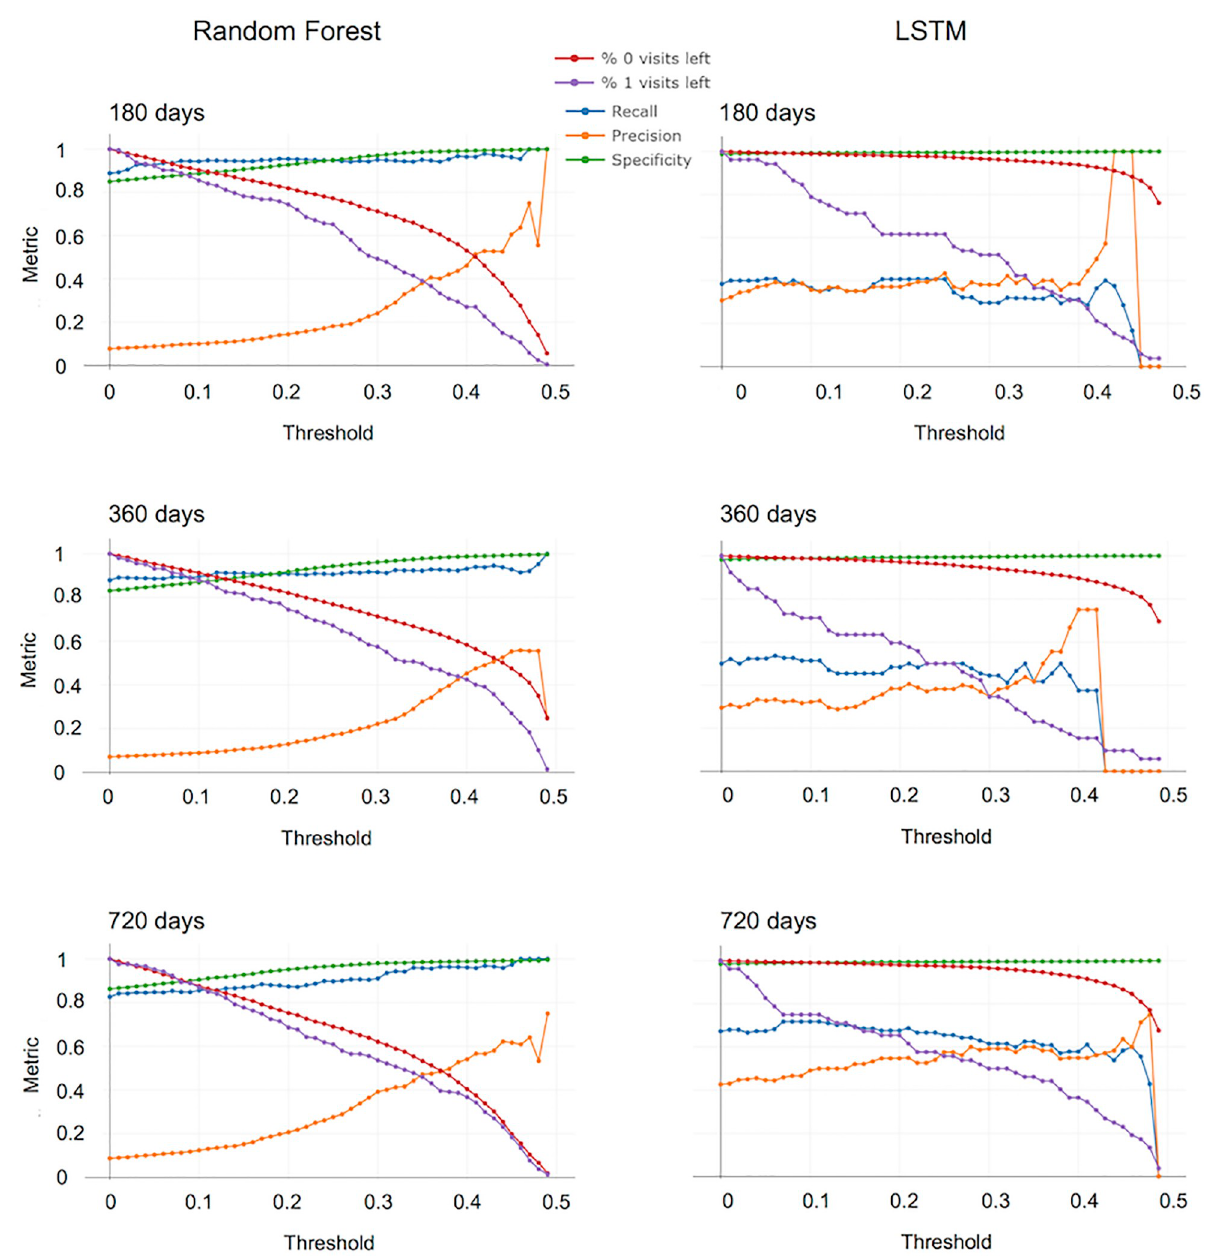
Fig 2. Threshold analysis. The choice of confidence threshold has different effects on the indicated variables. Analysis was performed with Random Forest and LSTM for Record Preserving datasets. https://doi.org/10.1371/journal.pone.0230219.g002 0.5. In particular, Recall and Precision are 0 when the number of TP is 0 and the metric is ill- defined. Recall values of RF model are always greater than 0.8, and increase for high confi- dence thresholds. This behaviour is observed at all time points. For LSTM, on the other hand, Recall values improve when dealing with longer time-windows, independently of the threshold chosen. At all time points, Recall values are little affected by CT , although a small increase is